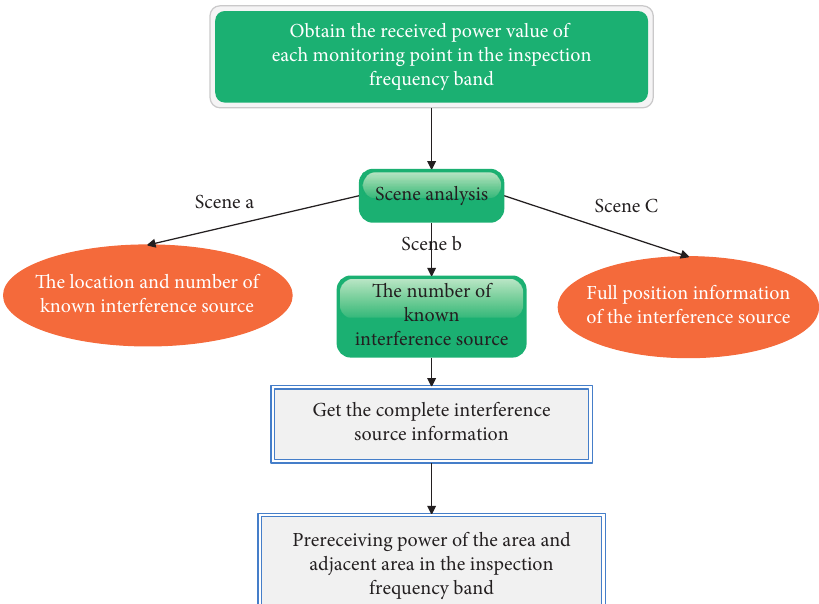
Figure 5: Flow chart of spectrum information